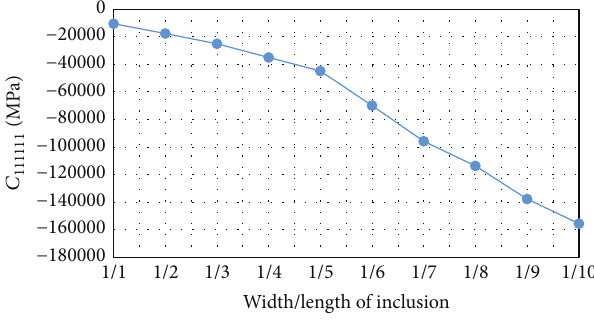
(1) 𝐶 111111 forreinforcedplexiglas